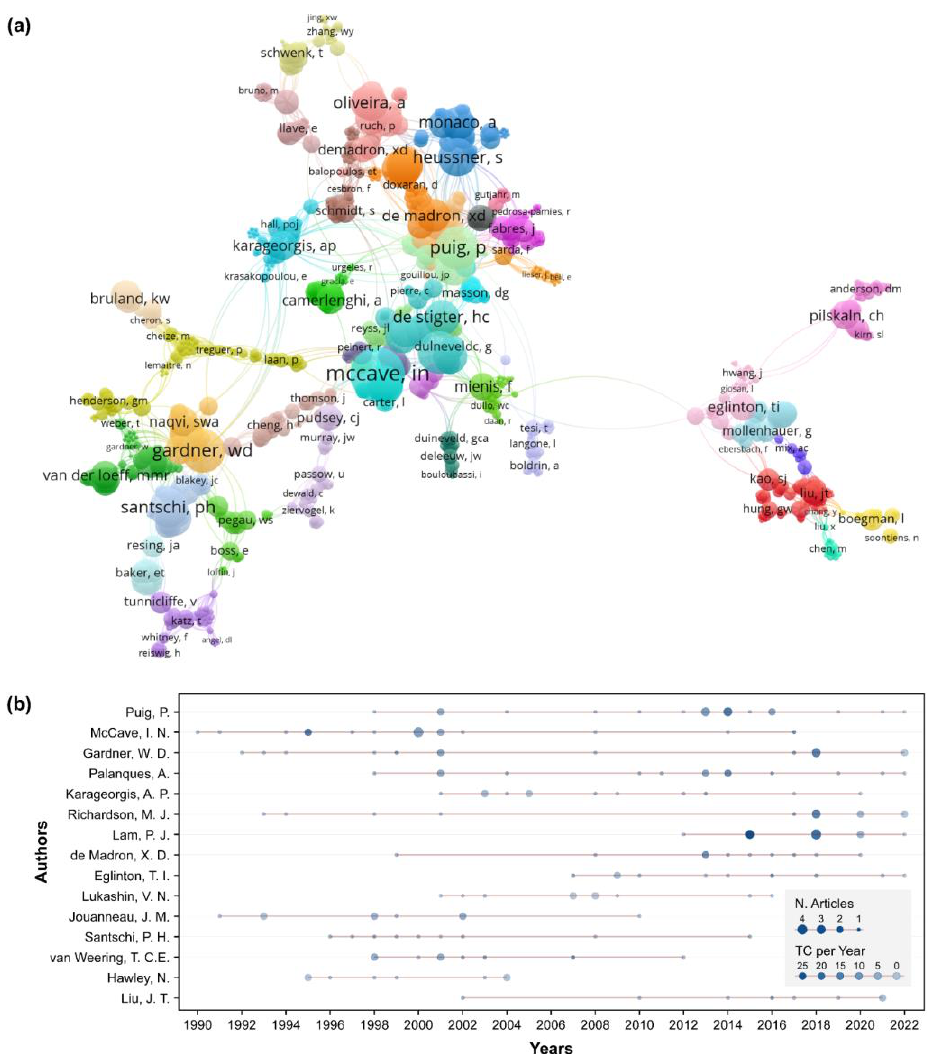
Figure 9. Bibliometric analysis of author influence from 1990 to 2022 [1–3,7,8,10,12,20,21,28–31,38,39,41,45,50,63,67,69,70,76–78]. ( a ) The author co-occurrence analysis network of 1062 most expressive authors. The size of the circles, which denotes its significance, is indicated as the number of citations for each author. ( b ) Temporal trends of an annual number of publications from the top 15 most productive authors. The number of publications (No. of articles) is shown by the size of the circles, and the overall number of citations every year is represented by the color of the circles (TC per year).